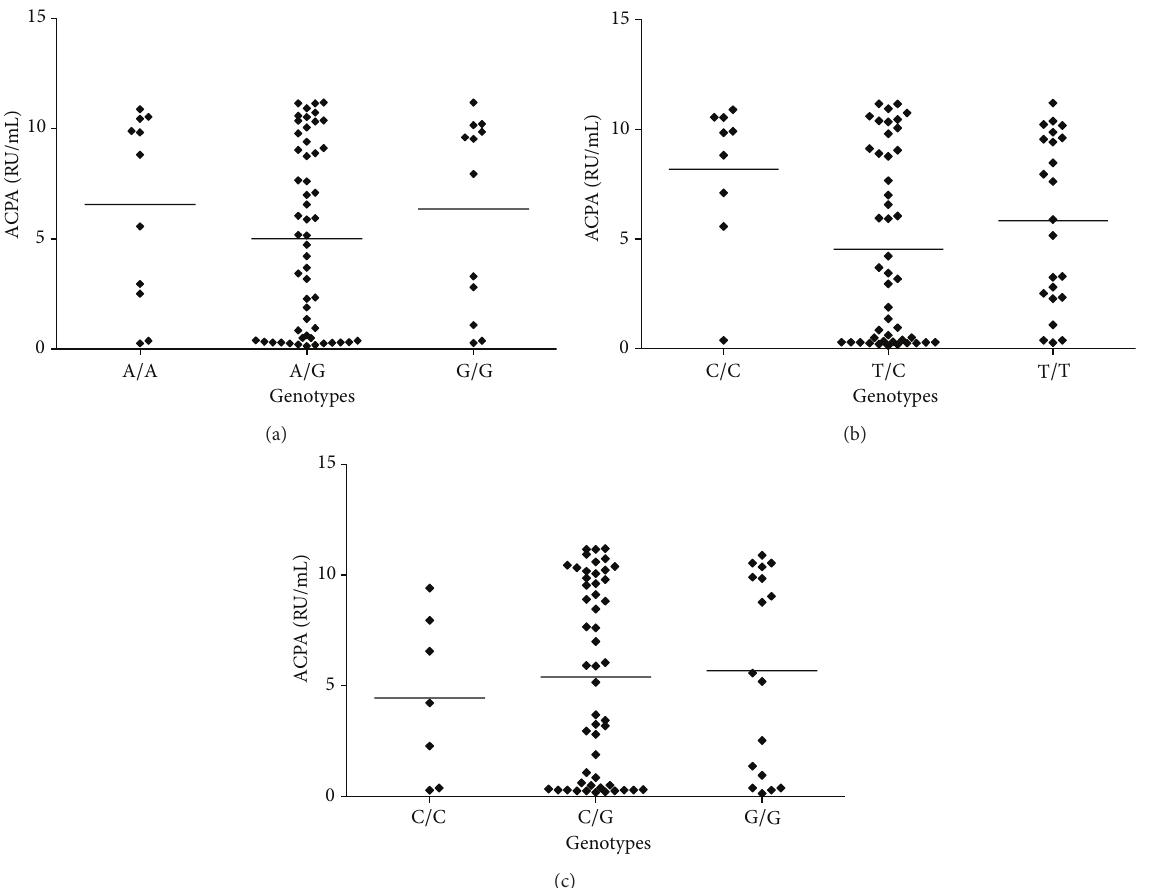
Figure2:Anti-cycliccitrullinatedpeptideantibodies(ACPA)titersinthepresenceofgeneticvariantsinPADI4 89,PADI4 90,andPADI4 92 polymorphisms of PADI4